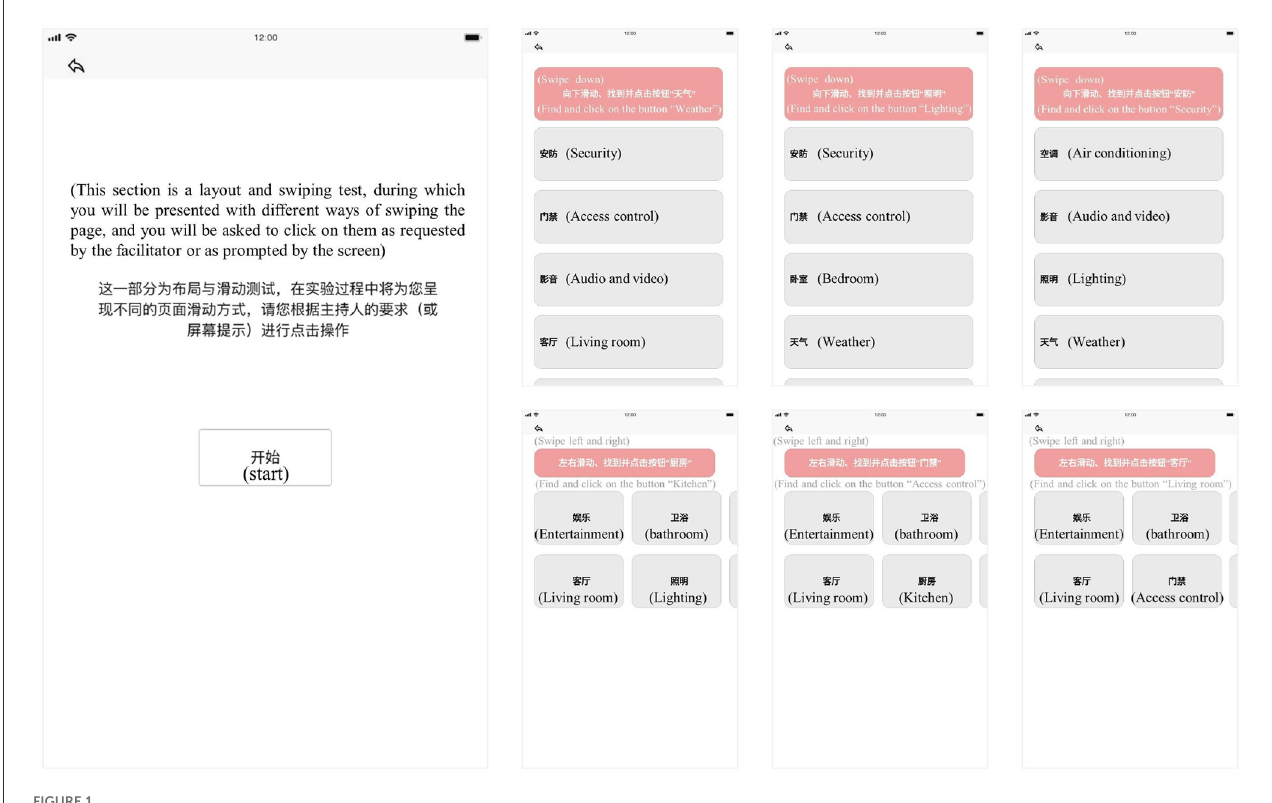
FIGURE1 Smart home interface materials for experimental use.